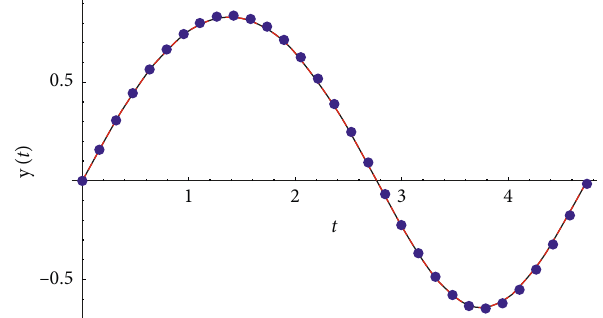
Figure 3: Comparison between the exact solution and the finite element method for n �